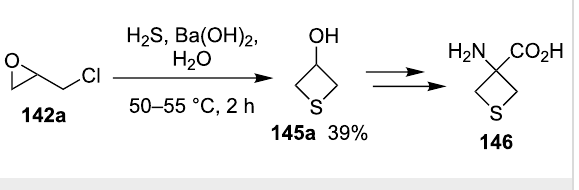
Scheme 29: Synthesis of thietane-3-ol 145a from chloromethyloxirane ( 142a